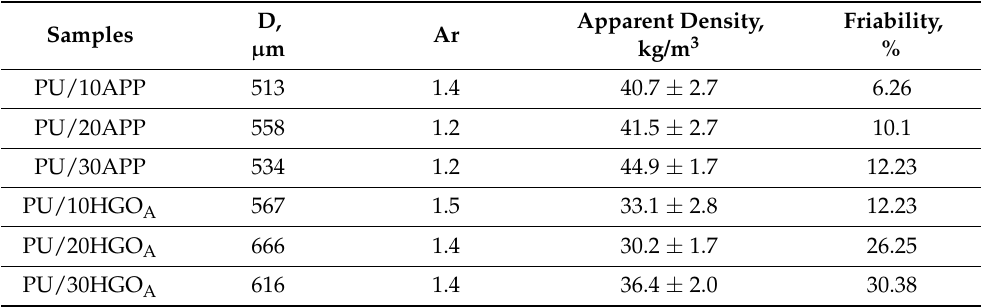
Table 5. Physico-mechanical properties and main characteristics of the cellular structure of PU